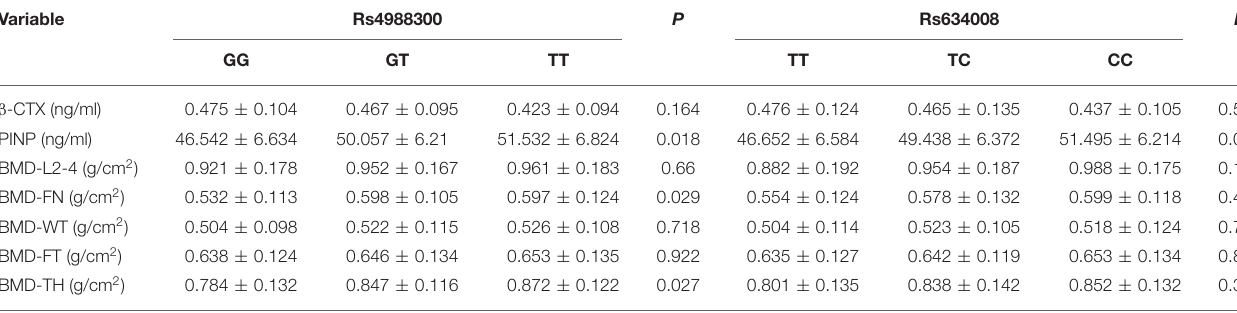
TABLE 4 | Relationships of SNPs genotyped with BTMs and BMDs in female with